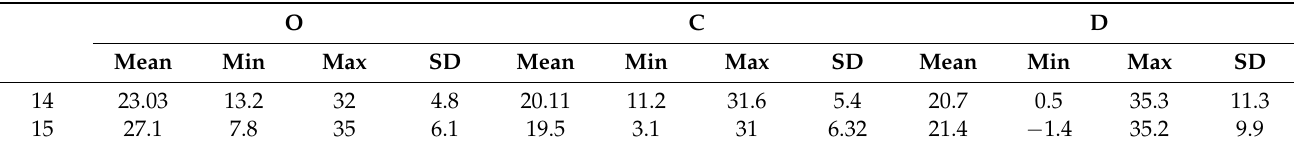
Table 15. PET descriptive statistics at each test point on the 14th and 15th ( ◦